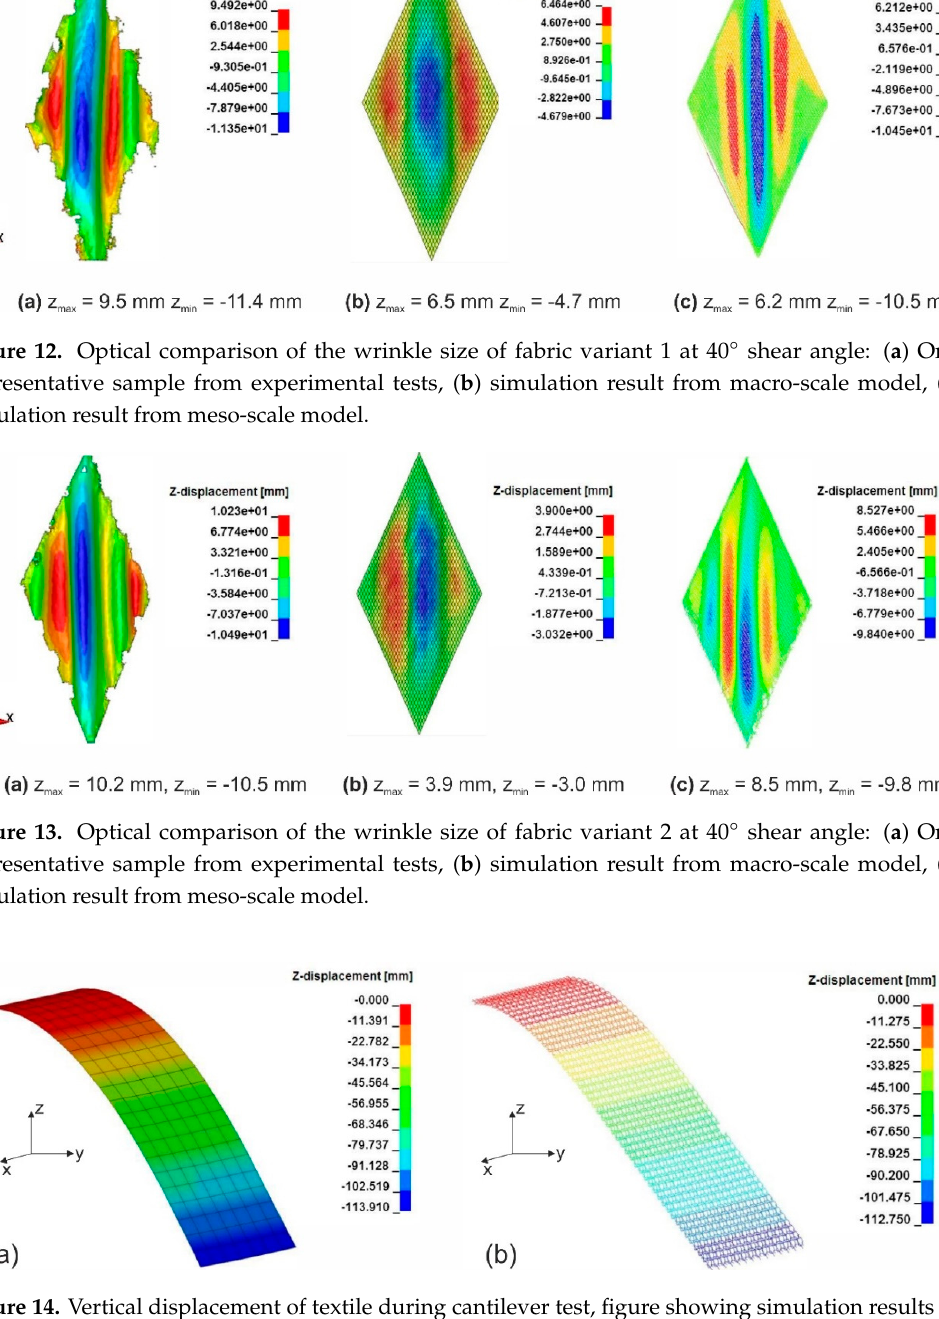
Figure 14. Vertical displacement of textile during cantilever test, figure showing simulation results of ( a ) macro-scale model and ( b ) meso-scale model for fabric variant 1 in the warp direction.